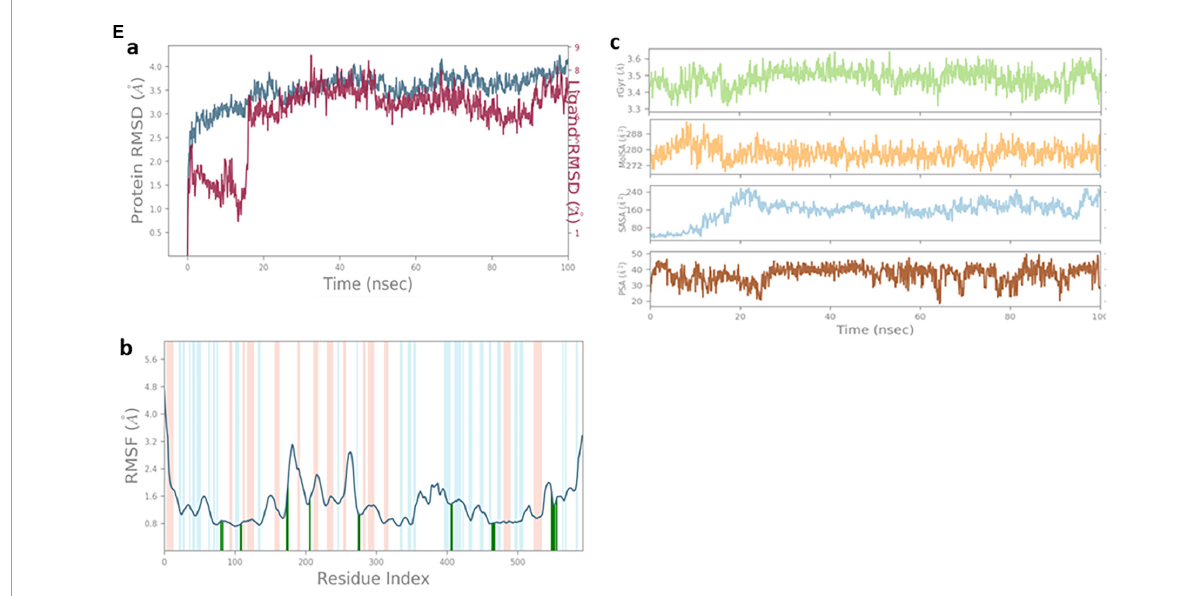
FIGURE7 Stability of protein and pesticide interactions. (A) Molecular dynamics simulation of α / β hydrolase (GM298_18675)–crotoxyphos complex, (a) protein–ligand RMSD, (b) protein RMSF, and (c) Rg, MolSA, SASA, and PSA. (B) Carboxylesterase–coumaphos complex, (a) Protein–ligand RMSD, (b) protein RMSF, and (c) Rg, MolSA, SASA, and PSA. (C) α / β hydrolase (GM298_08590)–cypermethrin complex, (a) Protein–ligand RMSD, (b) protein RMSF, and (c) Rg, MolSA, SASA, and PSA. (D) α / β hydrolase (GM298_00815)–diazinon complex, (a) Protein–ligand RMSD, (b) protein RMSF, and (c) Rg, MolSA, SASA, and PSA. (E) Amidohydrolase (GM298_20245)–chlorpyrifos complex, (a) protein–ligand RMSD, (b) protein RMSF, and (c) Rg, MolSA, SASA, and